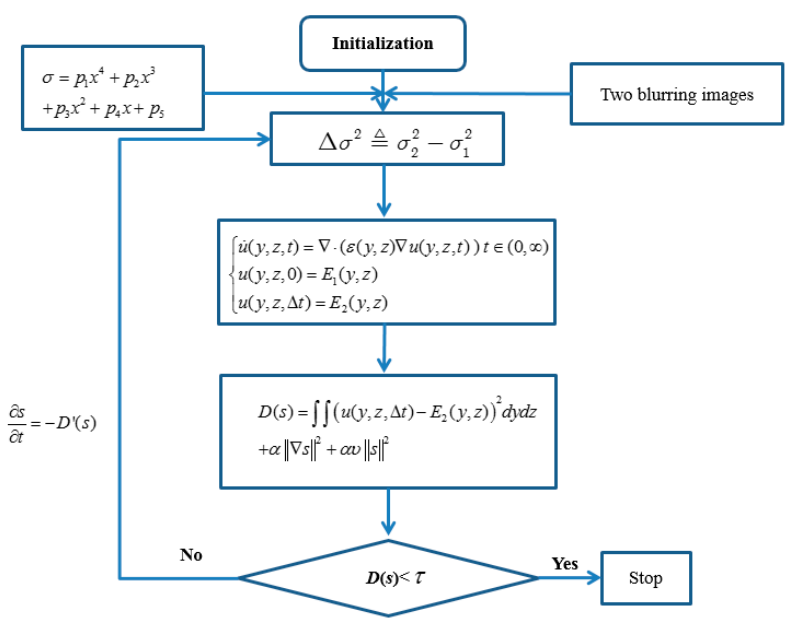
Figure 6. The process diagram of our method.